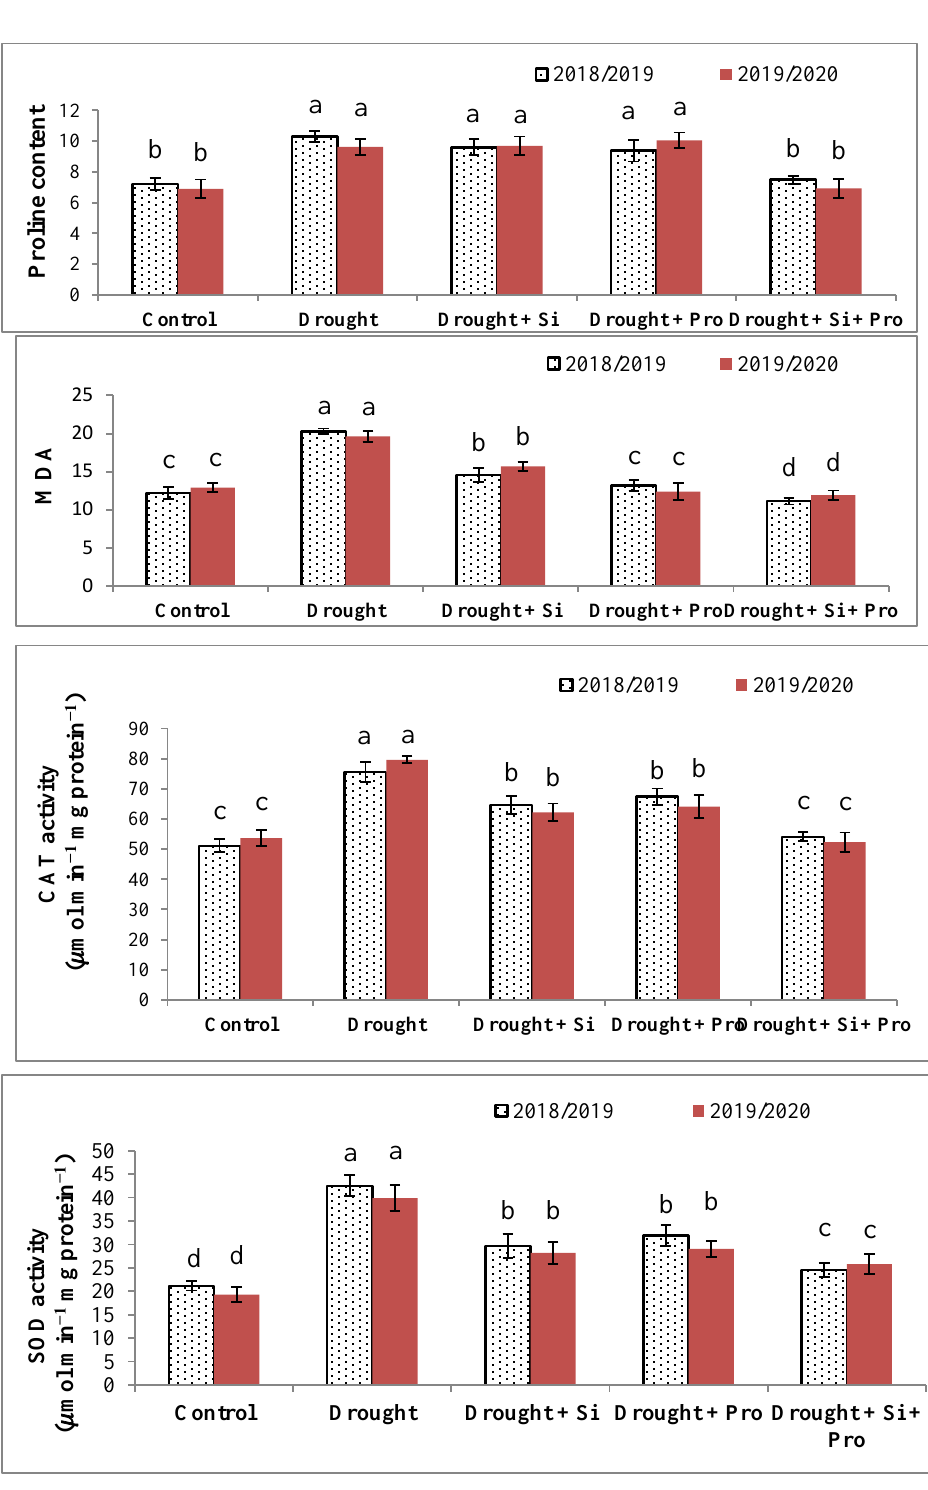
Figure 4. Effect of silicon and proline on proline content ( A ), lipid peroxidation (MDA) ( B ), antioxi- dant enzymes catalase (CAT) activity ( C ) and superoxide dismutase (SOD) activity ( D ) of sugar beet plants under drought in the 2018/2019 and 2019/2020